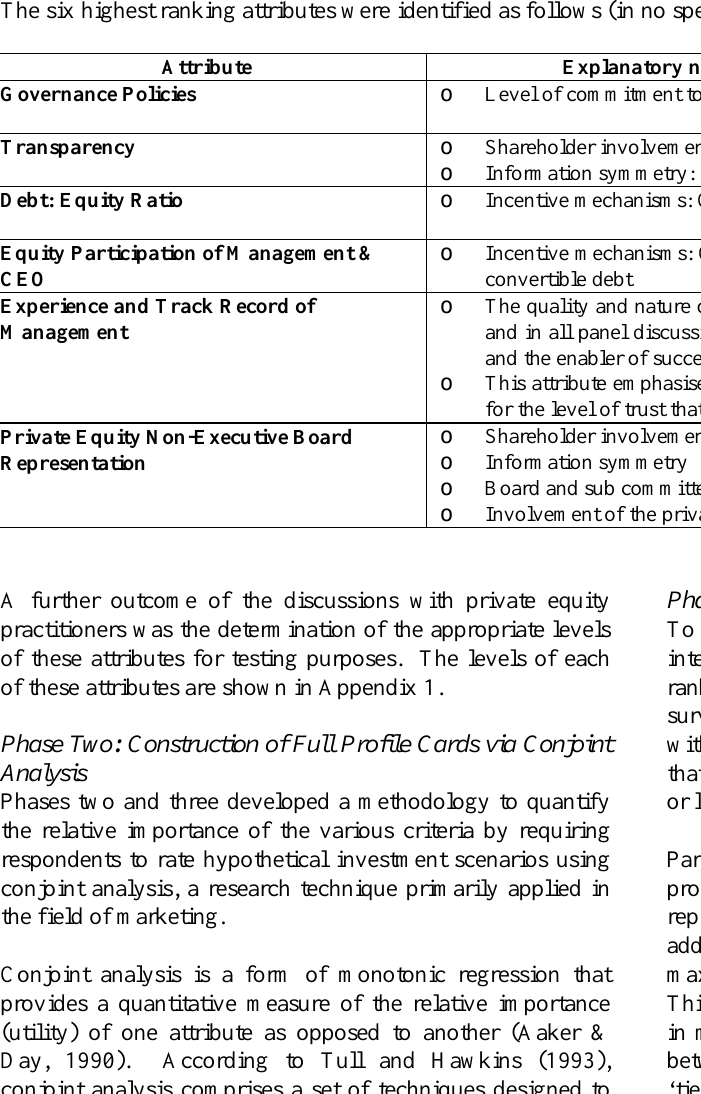
Table 1: Identification of attributes The six highest ranking attributes were identified as follows (in no specific